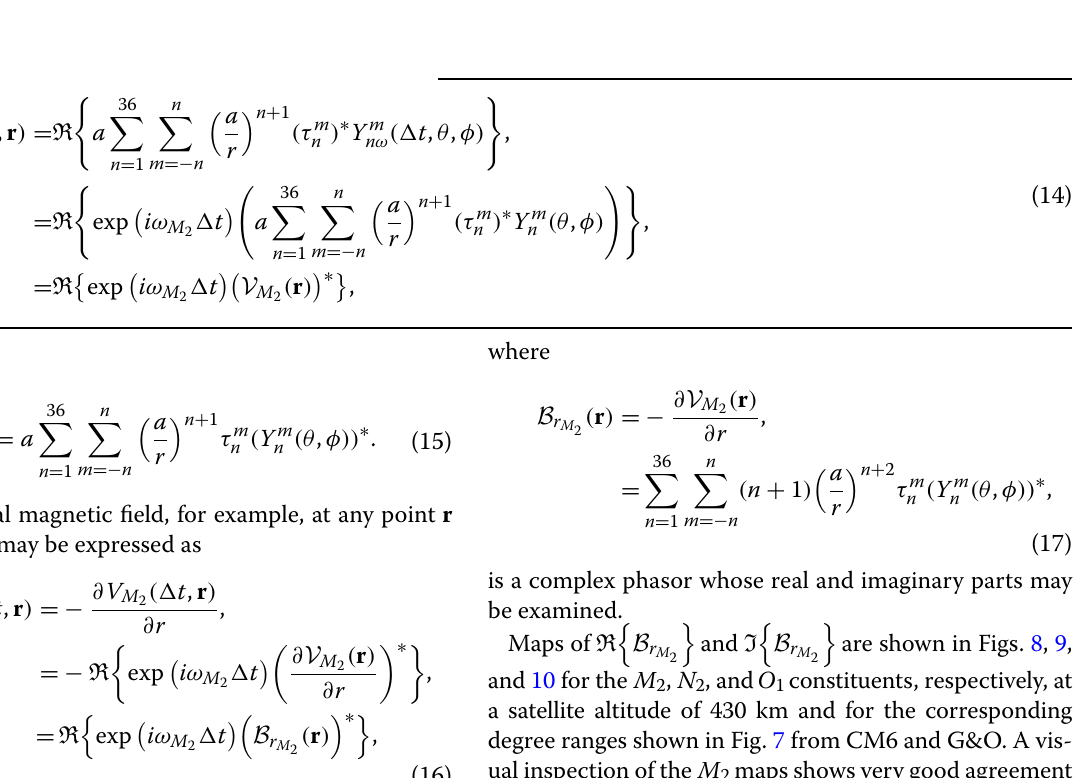
Fig. 9 Real (left) and imaginary (right) parts of the radial component of the N 2 oceanic tidal magnetic field for SH degrees n altitude from CM6 (top) and G&O